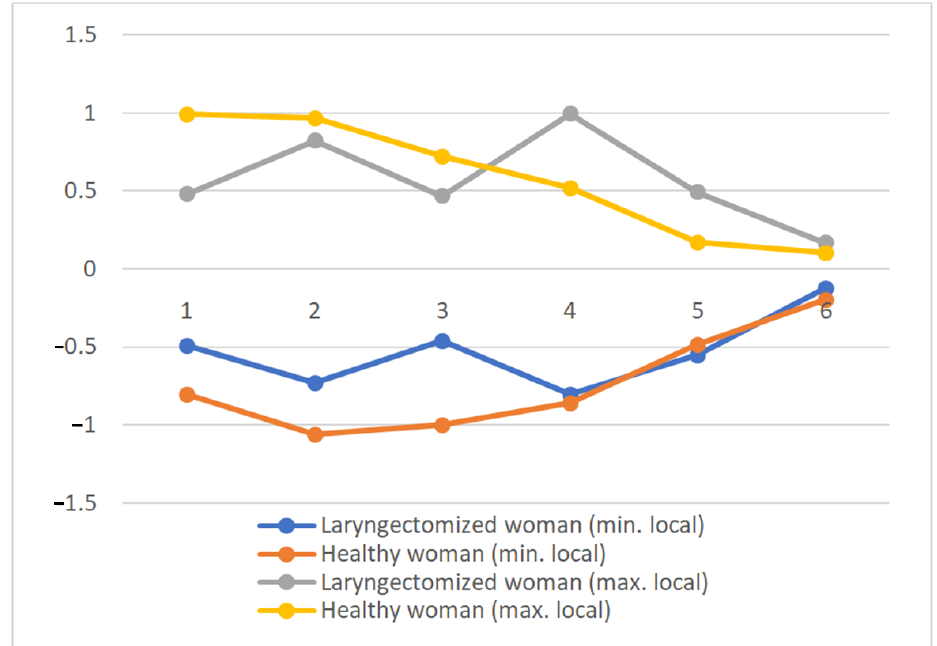
Figure 13. Local minimum and local maximum distributions for the first phonetic segment of the word „barrel” (in Polish “ beczka ” ).